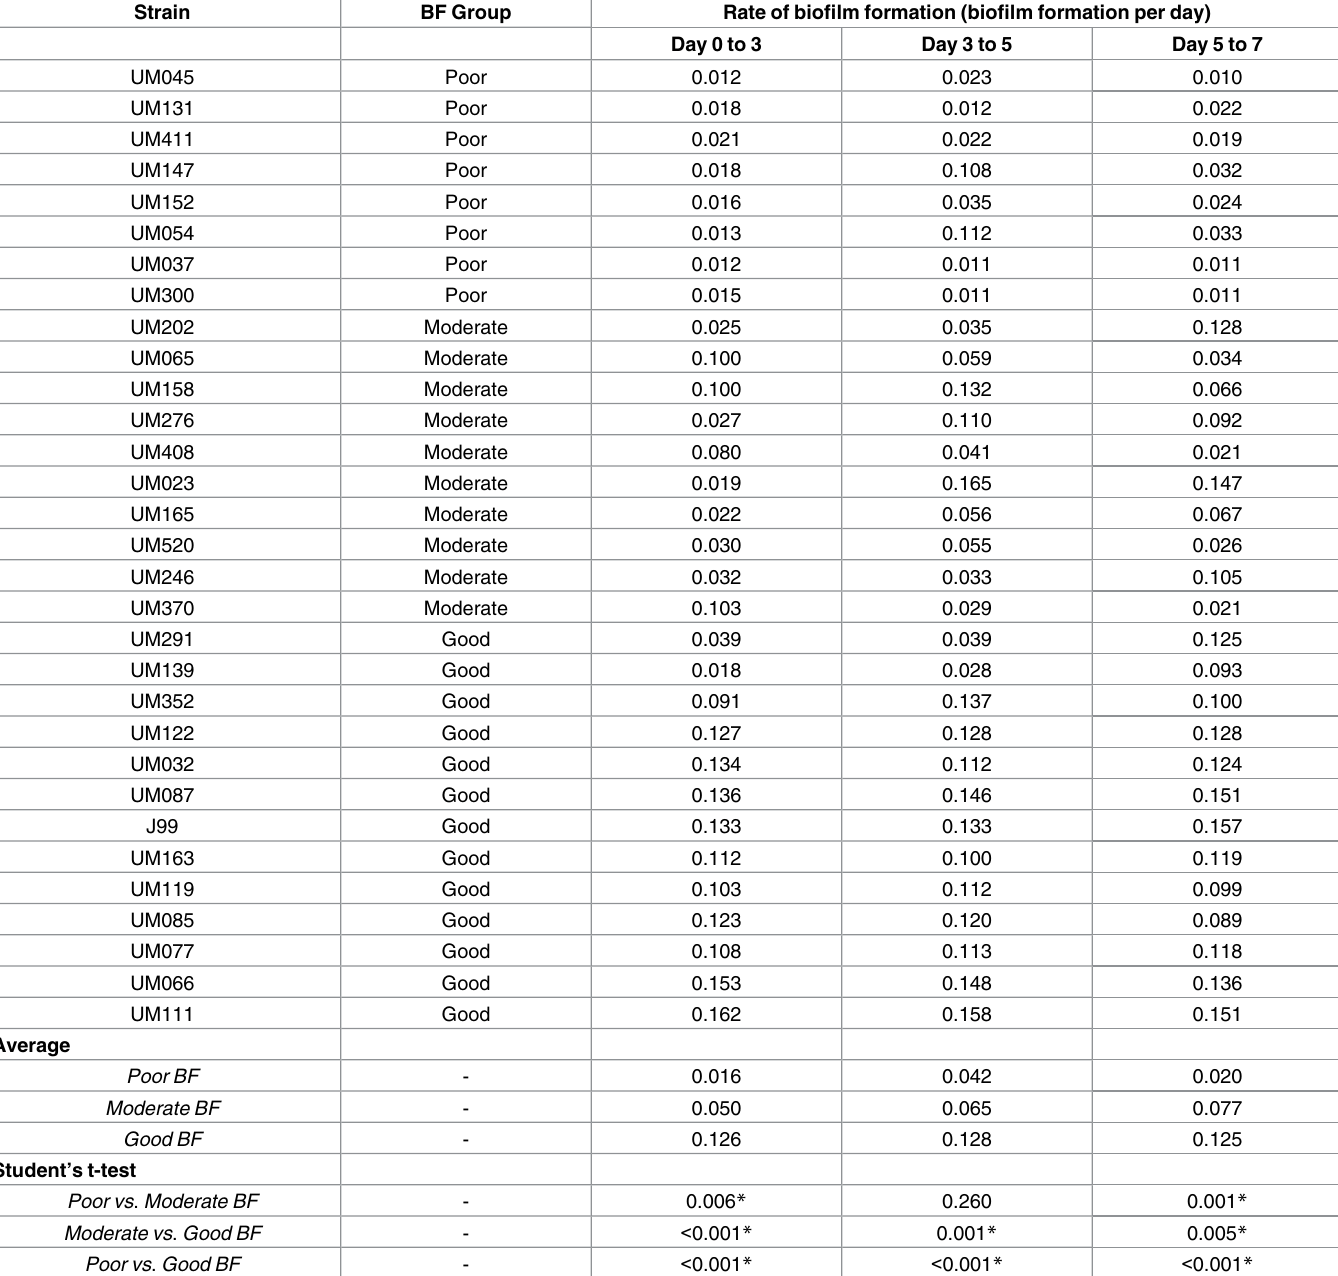
Table 4. The rate of biofilm formation for all the H . pylori strains which were used in this study. Statistical significancefor differences in rate of biofilm formation across time points was determinedby two-tailed Student’s t-test. Strain BF